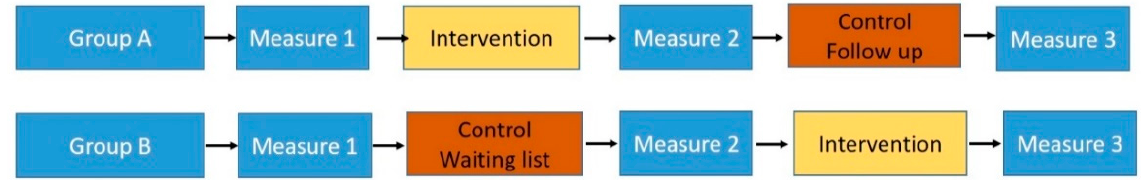
Figure 2. Diagram of the design of repeated measures with alternate treatment control groups.